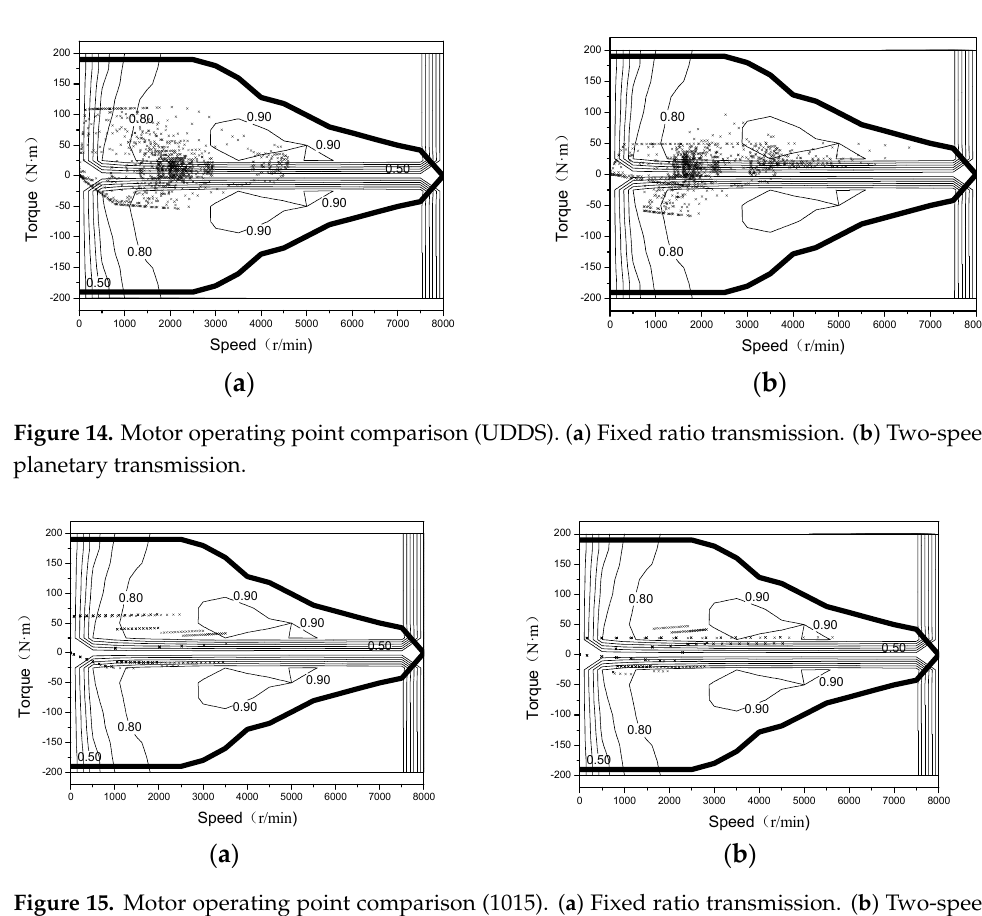
Figure 13. Motor operating point comparison (ECE). ( a ) Fixed ratio transmission. ( b ) Two-speed planetary transmission.